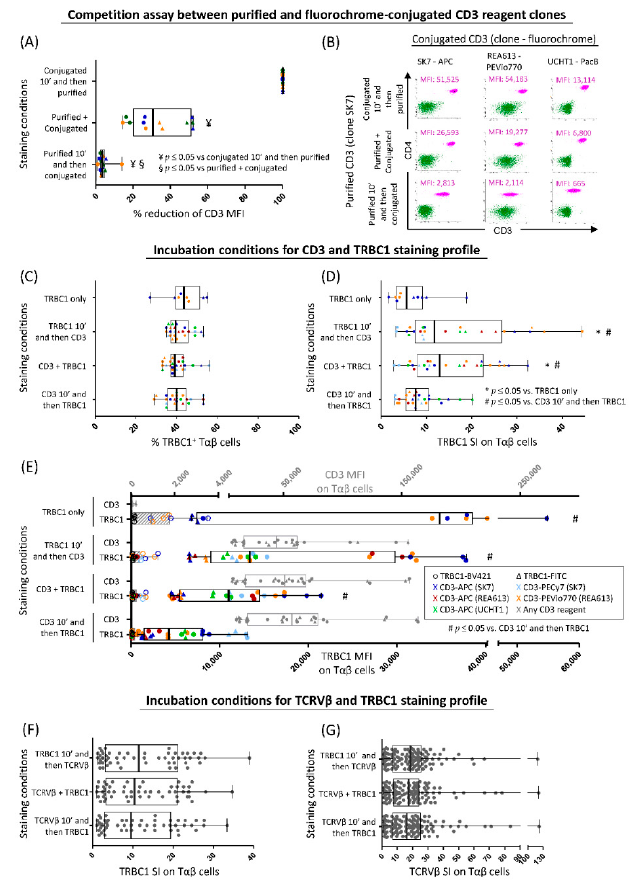
Figure 2. Impact of CD3 and TCRV β antibody staining on the expression profile of TRBC1. ( A ) Competition assays performed in 6 paired PB samples stained with different fluorochrome-conju- gated CD3 clones ( n = 3, SK7, REA613 and UCHT1) and unconjugated (=purified) CD3 reagents (SK7 and UCHT1) clones, tested under three different incubation conditions: (a) addition of the